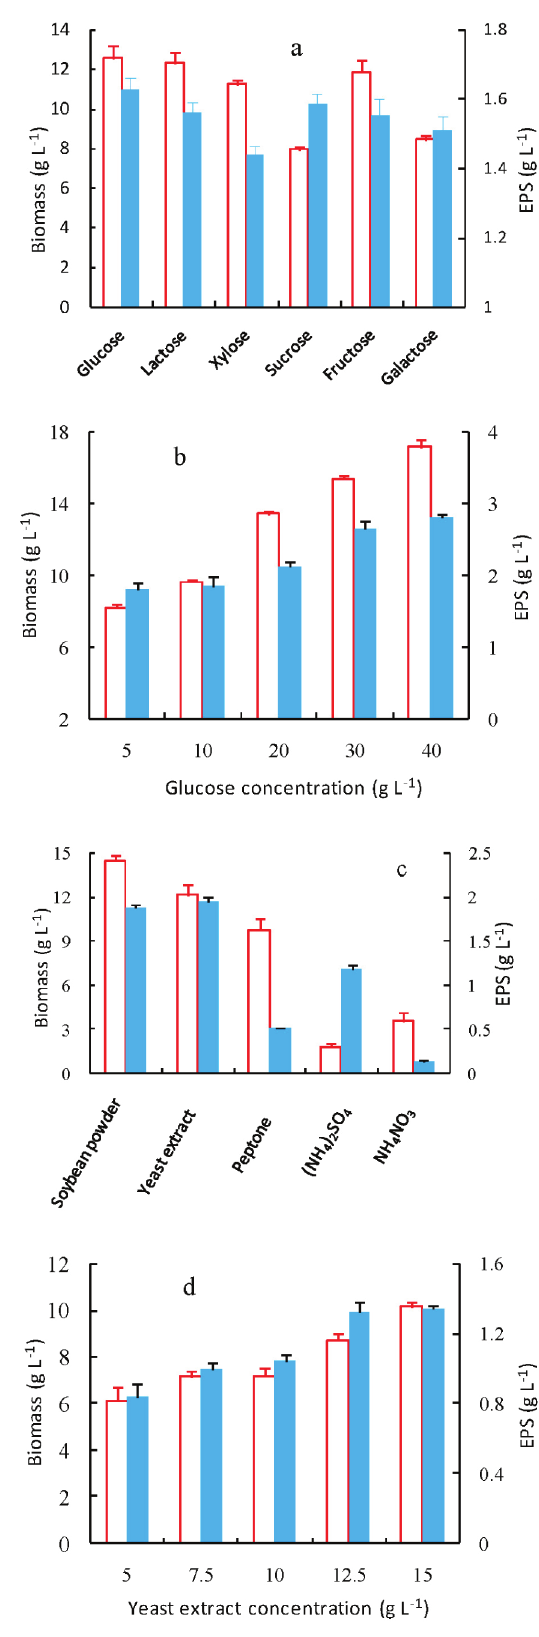
Fig. 1 – Effects of carbon sources (a), glucose concentration (b), nitrogen sources (c) and yeast extract concentration (d) on mycelial growth and EPS biosynthesis by H. marmoreus. EPS (■) and biomass